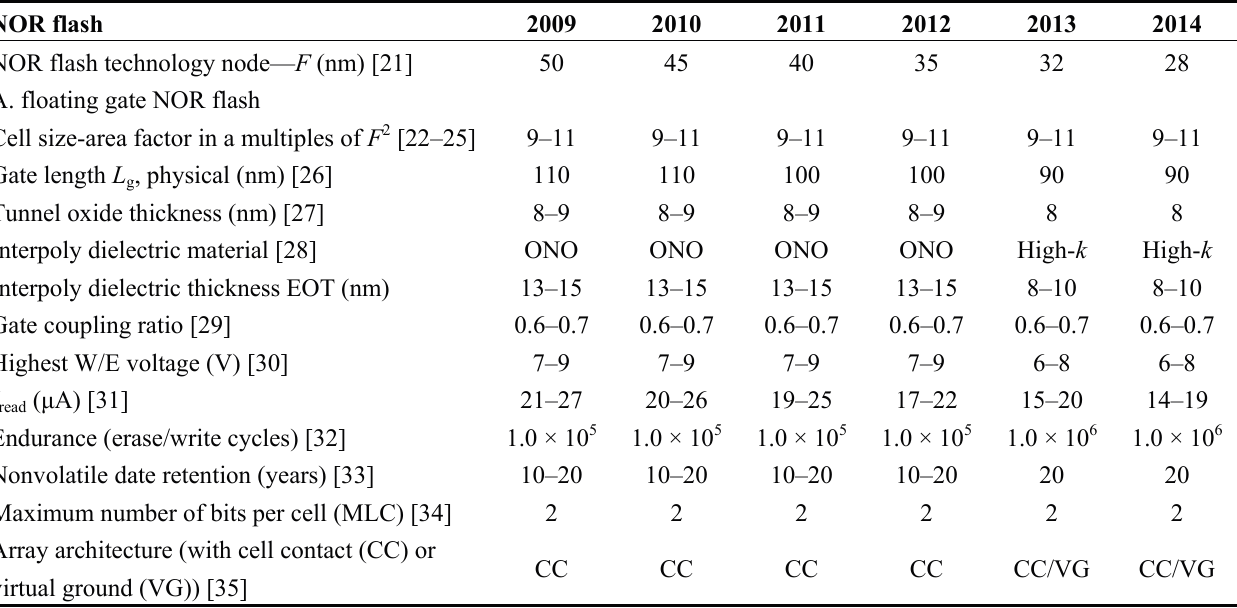
Table 1. International Technology Roadmap for Semiconductors (ITRS) Scaling projections for floating-gate NOR flash